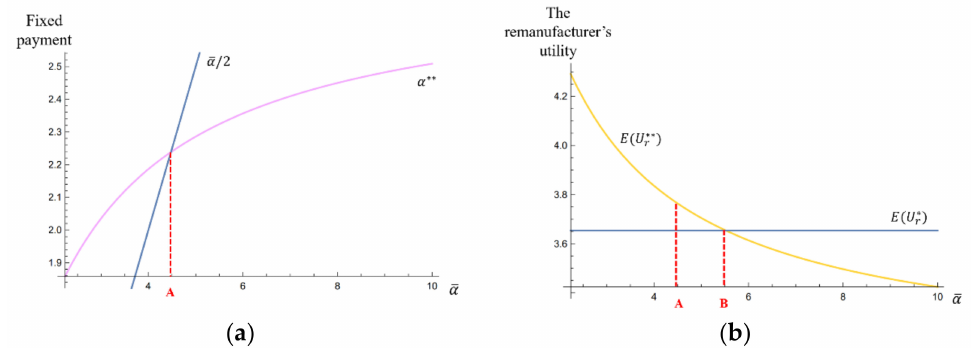
Figure 3. The e ff ects of the highest fixed payment α on ( a ) the fixed payment α ∗∗ , and ( b ) the remanufacturer’s utilities E ( U ∗ r ) and E ( U ∗∗ r ) (when the unit subsidy δ = 1